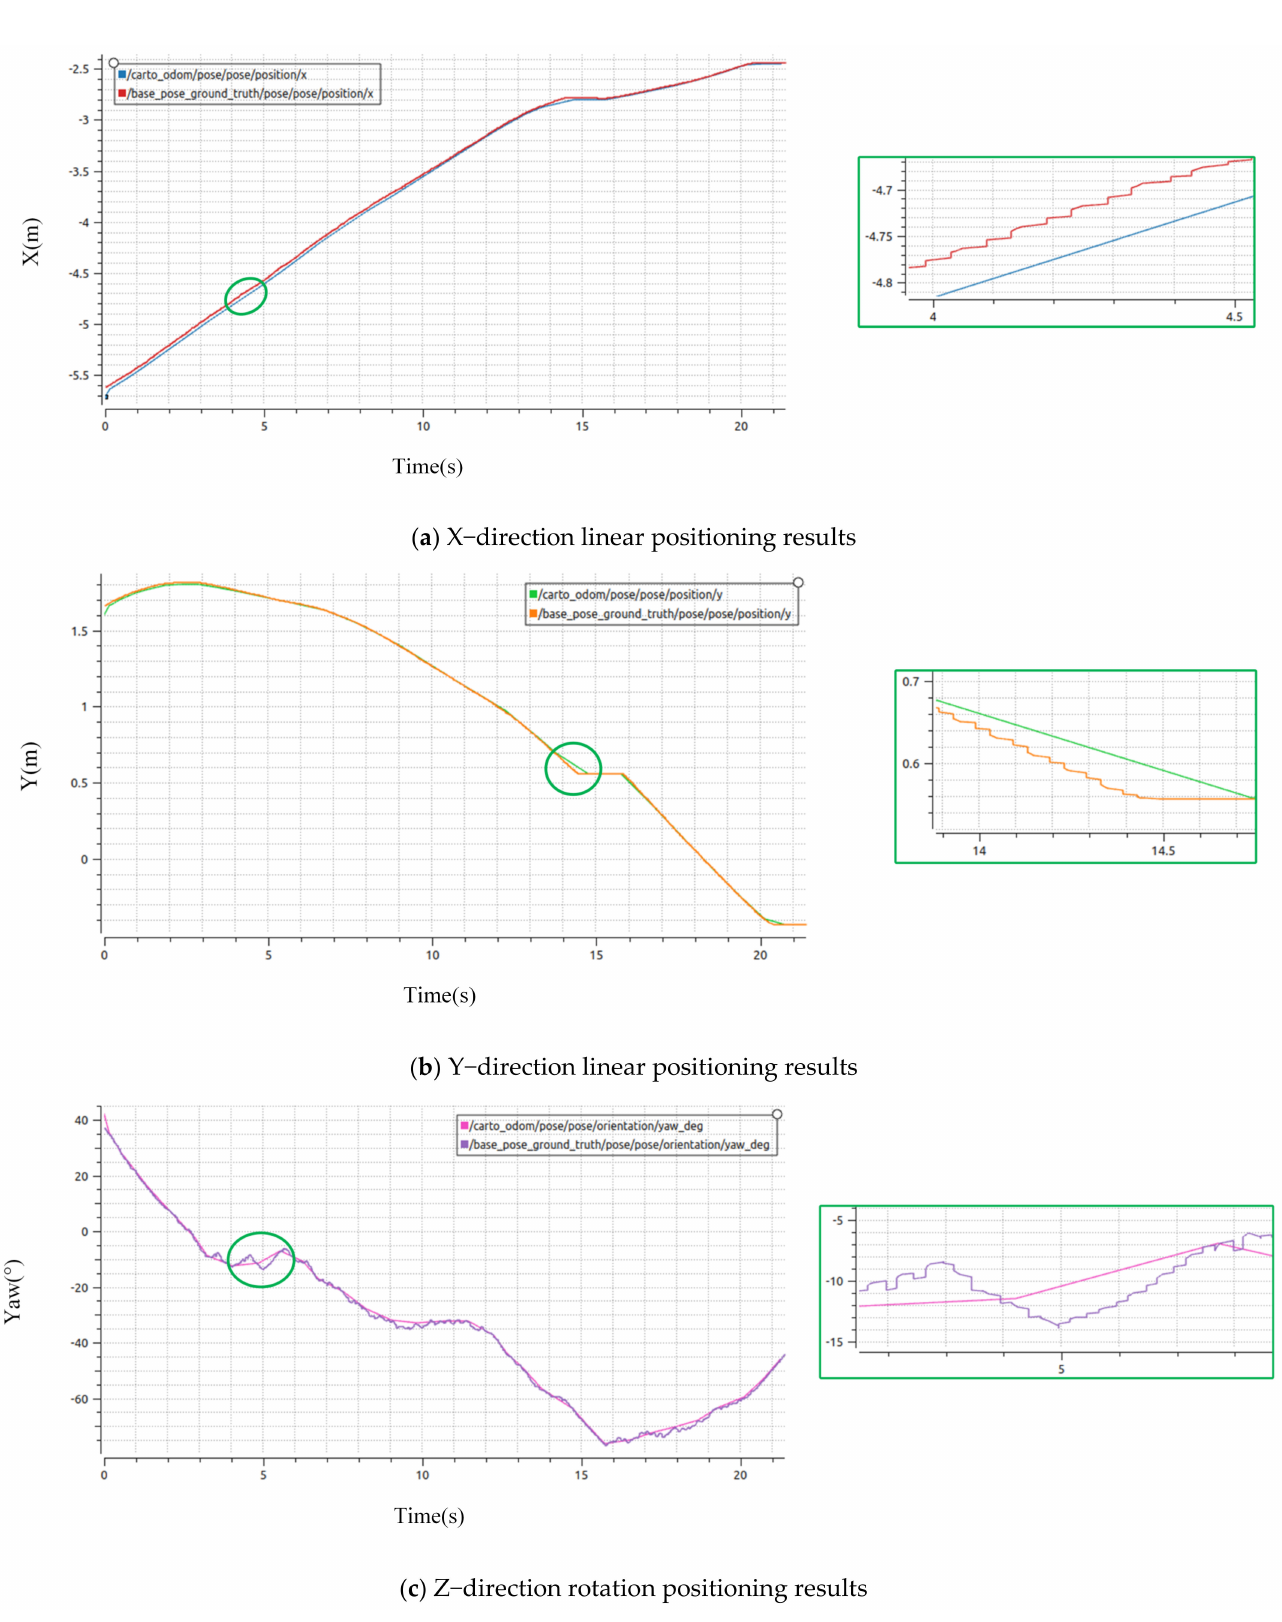
Figure 12. Results of the first group of cartographer simulation positioning